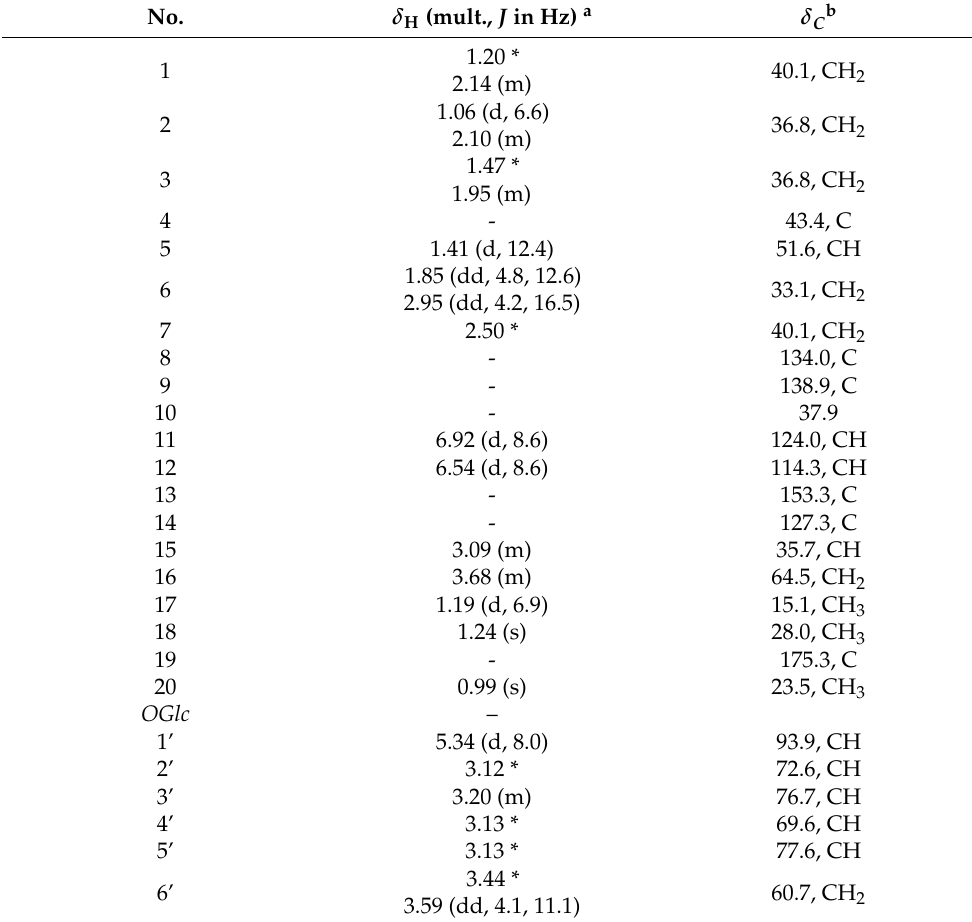
Table 2. 1 H- and 13 C-NMR data for compound 4 in DMSO- d 6